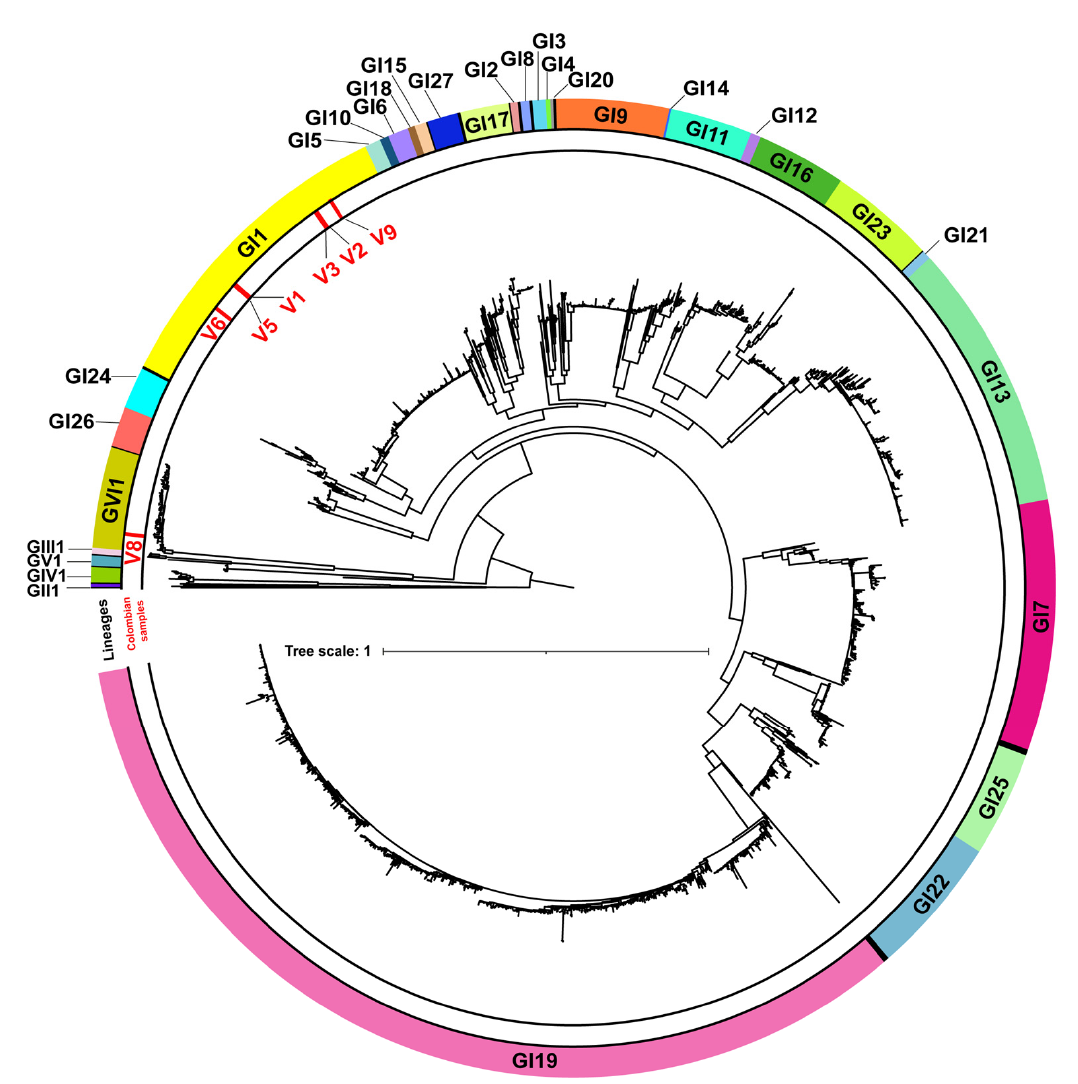
Figure 2. Maximum-likelihood (ML) phylogenetic tree of IBV S1 Colombian sequences ( n = 7), plus S1 IBV worldwide gene sequences ( n = 1972). The circular band of colors around the tree indicates the genotype and lineage of each clade. Black bands indicate unique variants as designated by Valastro et al. 2016. Red lines in the second layer (outer to inner) indicate the placement of the Colombian samples. The SH-aLRT support values were >99% for all the genotypes and defined lineages. The tree was midpoint rooted and the length of the branches are drawn to scale with the bar at the middle indicating nucleotide substitution per site.